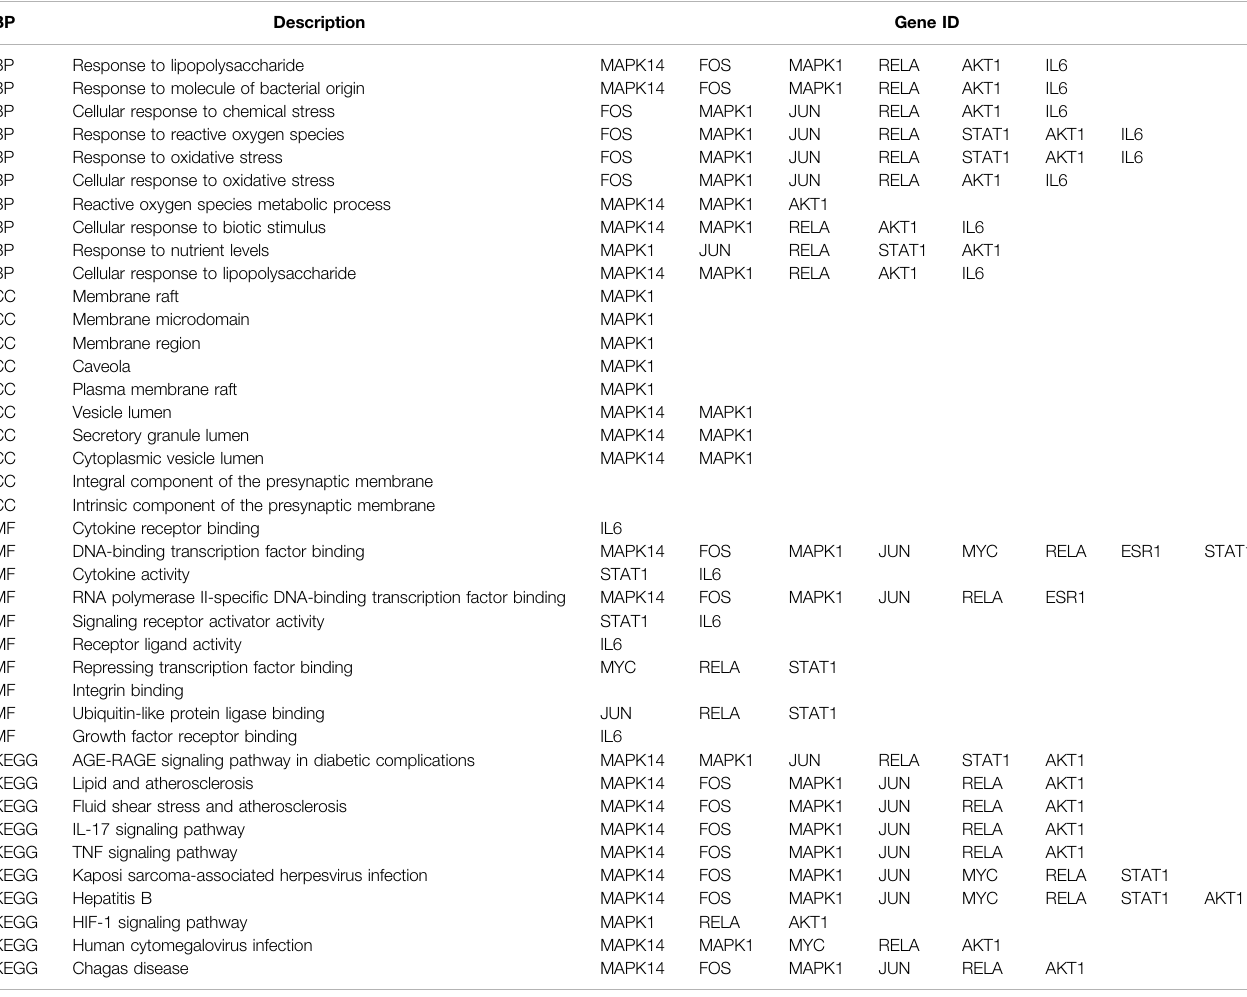
TABLE 5 | Hub genes enriched in GO and KEGG pathway